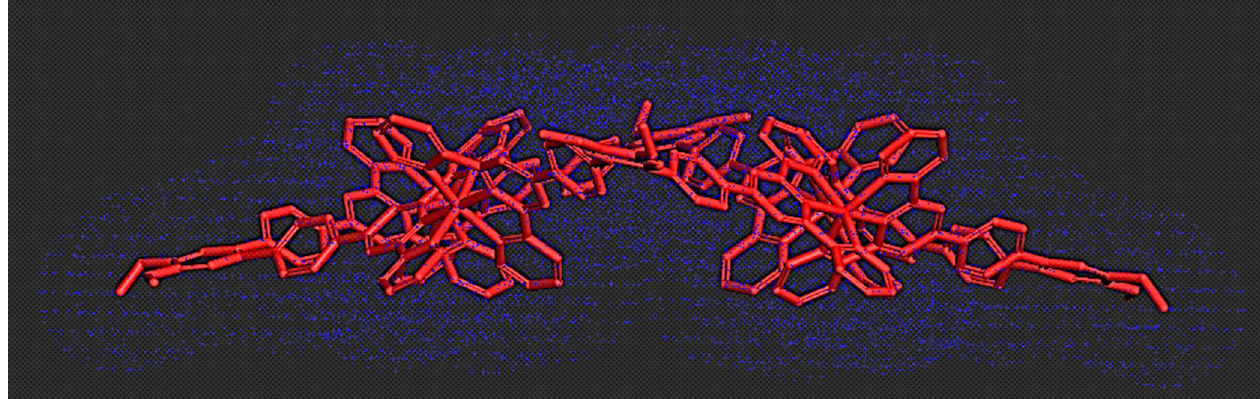
FIGURE 12 – Side view of a computer generated model of a tetrameric Dondorff ring showing the folded motif [Schultz, A.; Li, X.; McCusker, J. K.; Moorefield, C. N.; Castellano, F. N.; Wesdemiotis, C.; Newkome, G. R. Chem. Eur. J. , v.18, p.11569-11572, 2012. – Reproduced by permission of